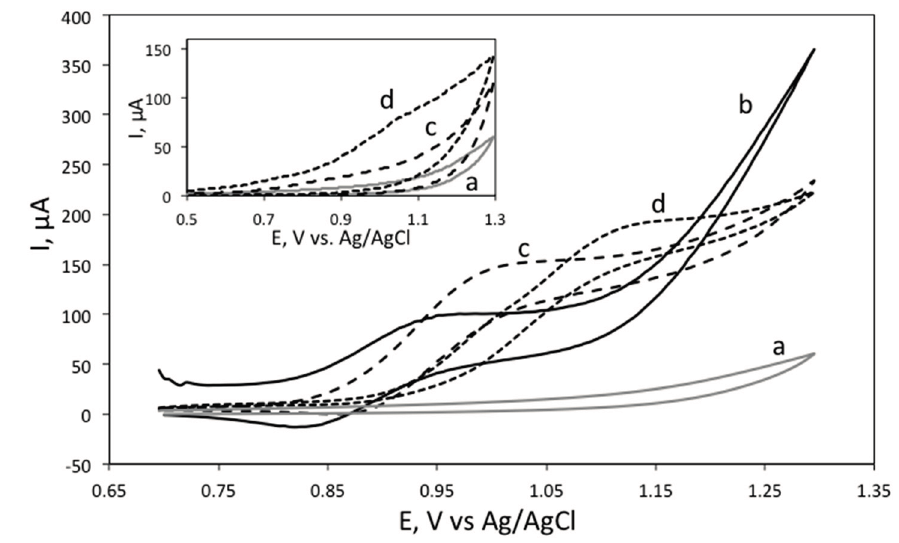
Figure 1. Cyclic voltammogram of 5 mM Ru(bpy) 32 solution alone (solid line, marked with b), in the presence of 100 μ M cadaverine (dashed line, c), and in the presence of 100 μ M putrescine (dotted line, d). Background (grey line, a) corresponds to 0.05 M tetraborate buffer, pH 9.2. Inset shows cyclic voltammograms of 100 mM cadaverine (dashed line, c) and putrescine (dotted line, d) in tetraborate buffer, pH 9.2 as well as buffer background (grey line, a).